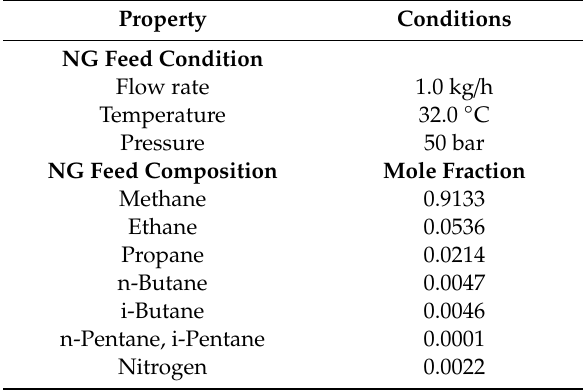
Table 3. Natural gas feed conditions and assumptions adapted from [25].